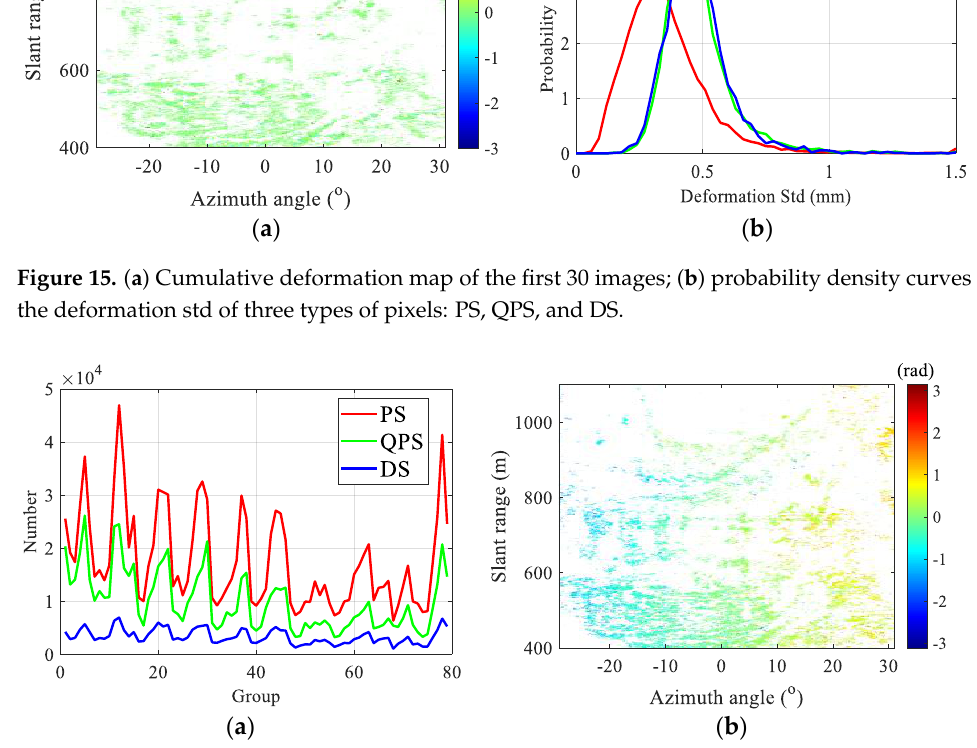
Figure 16. ( a ) Number curves of different types of HQPs for all the image groups. (b) Interferomet- ric phase map of the 12th group with the most HQPs. phase map of the 12th group with the most